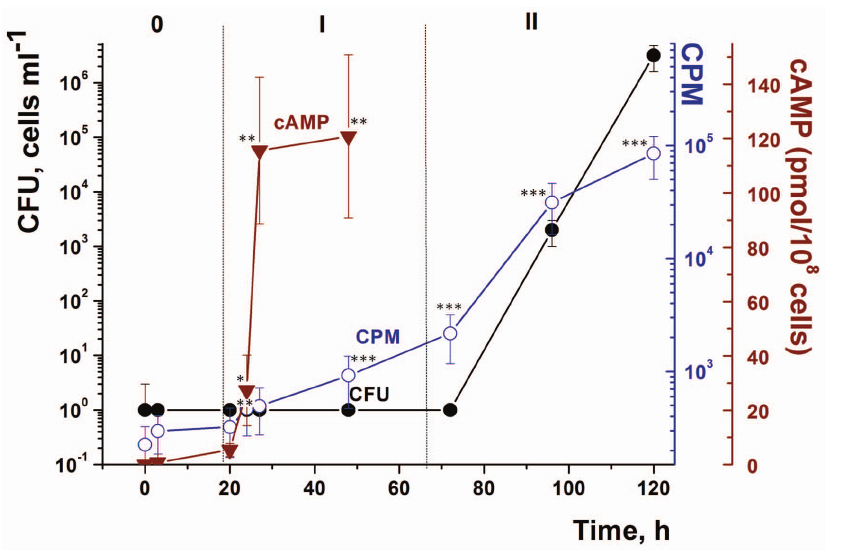
Figure 4. Comparison of the effects of linoleic acid and the uncoupler CCCP on the resuscitation of M.smegmatis NC cells. The resuscitation of NC cells was performed in MPN format. Each dilution was supplemented with linoleic acid or CCCP at the concentrations indicated. The ordinate shows the number of potentially viable (resuscitated) cells per ml of the initial NC population. This experiment was repeated twice with similar results; the error bars represent the standard error of the mean. Asterisks indicate that the result is significantly different from the control by Student’s t-test.